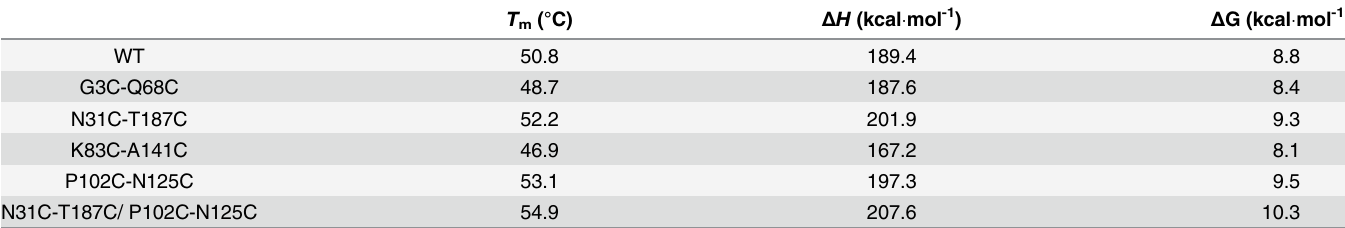
Table 3. Thermodynamic parameters of wild-type BglTM and the